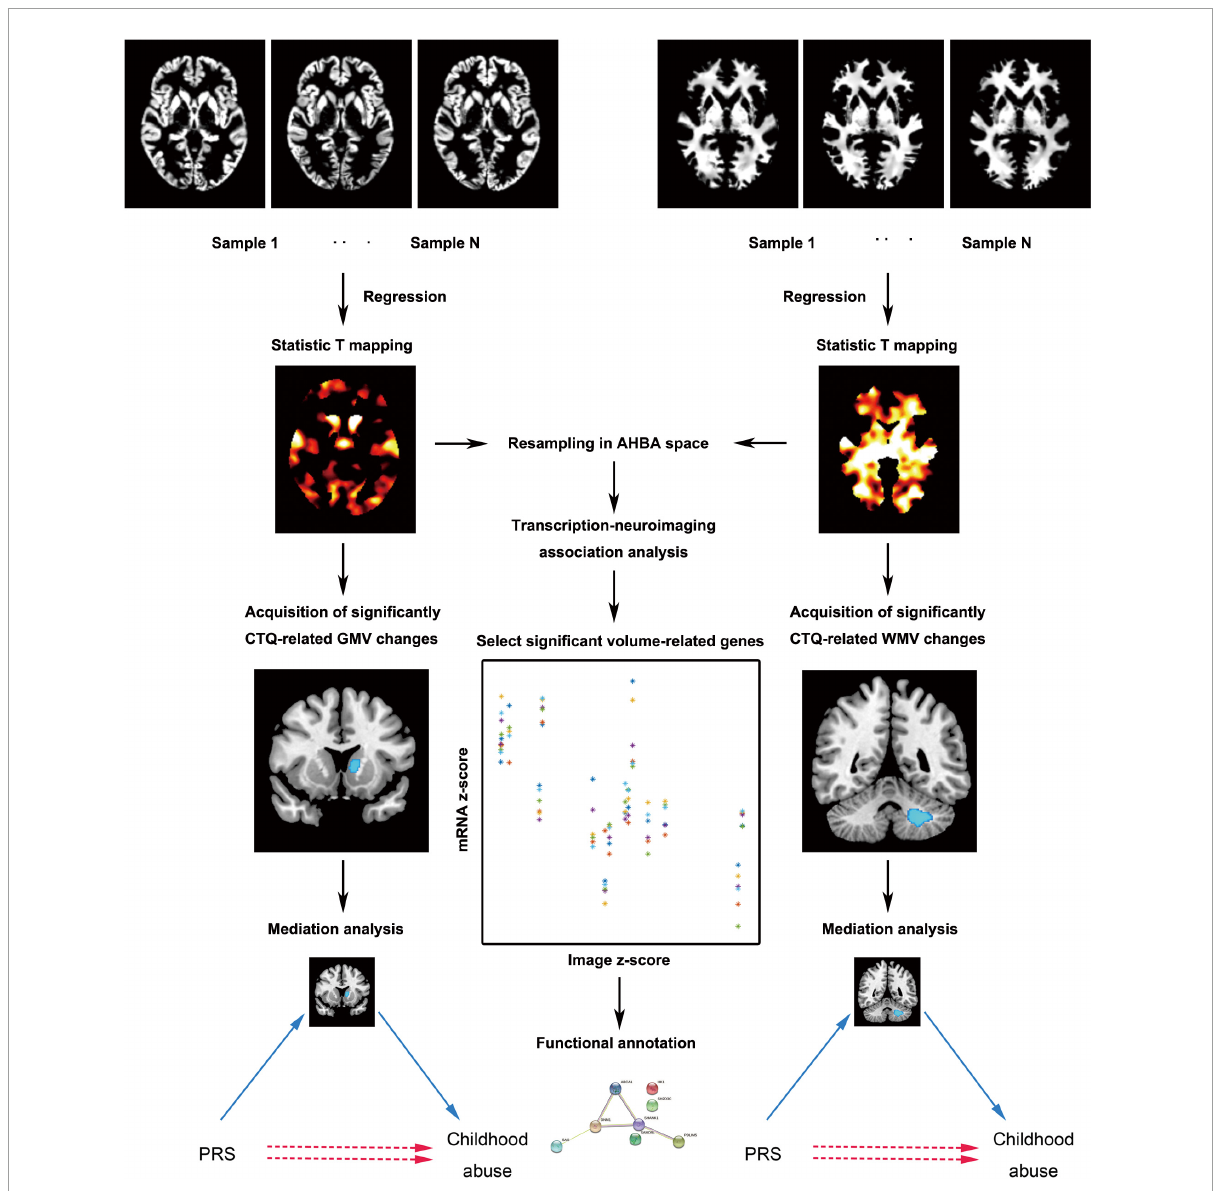
FIGURE1 The main analytic framework of this study. AHBA, Allen Human Brain Database; CTQ, Childhood Trauma Questionnaire; GMV, gray matter volume; PRS, polygenic risk score; WMV, white matter